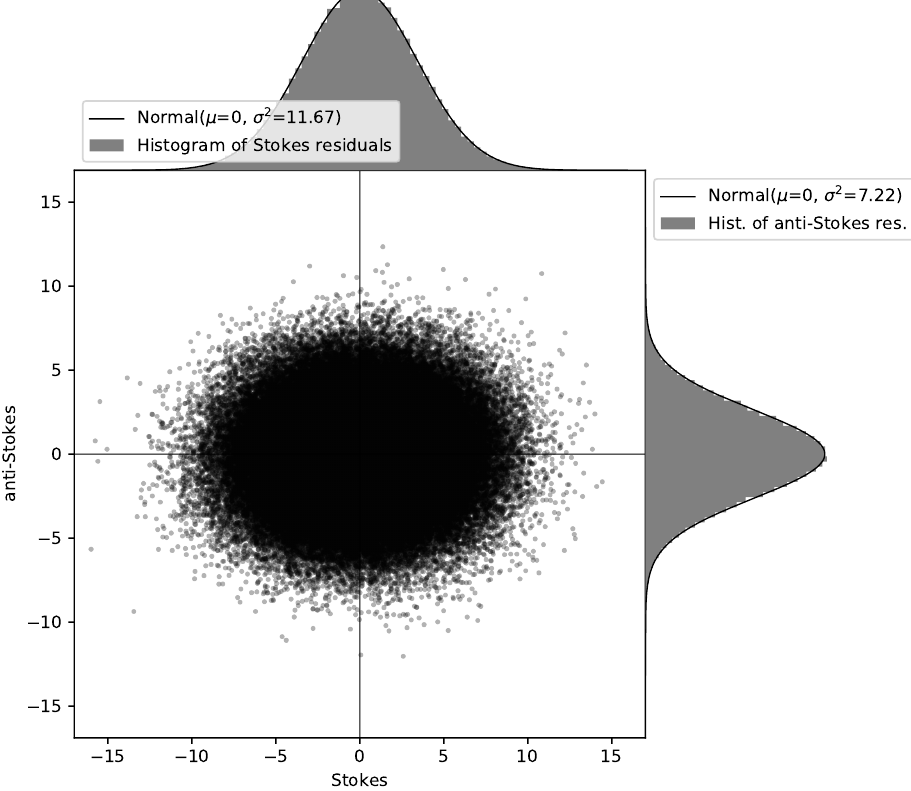
Figure A1. Stokes residuals plotted against the anti-Stokes residuals. The Stokes and anti-Stokes intensity recorded by the DTS instrument have arbitrary units that are linearly related to the power of the scattered